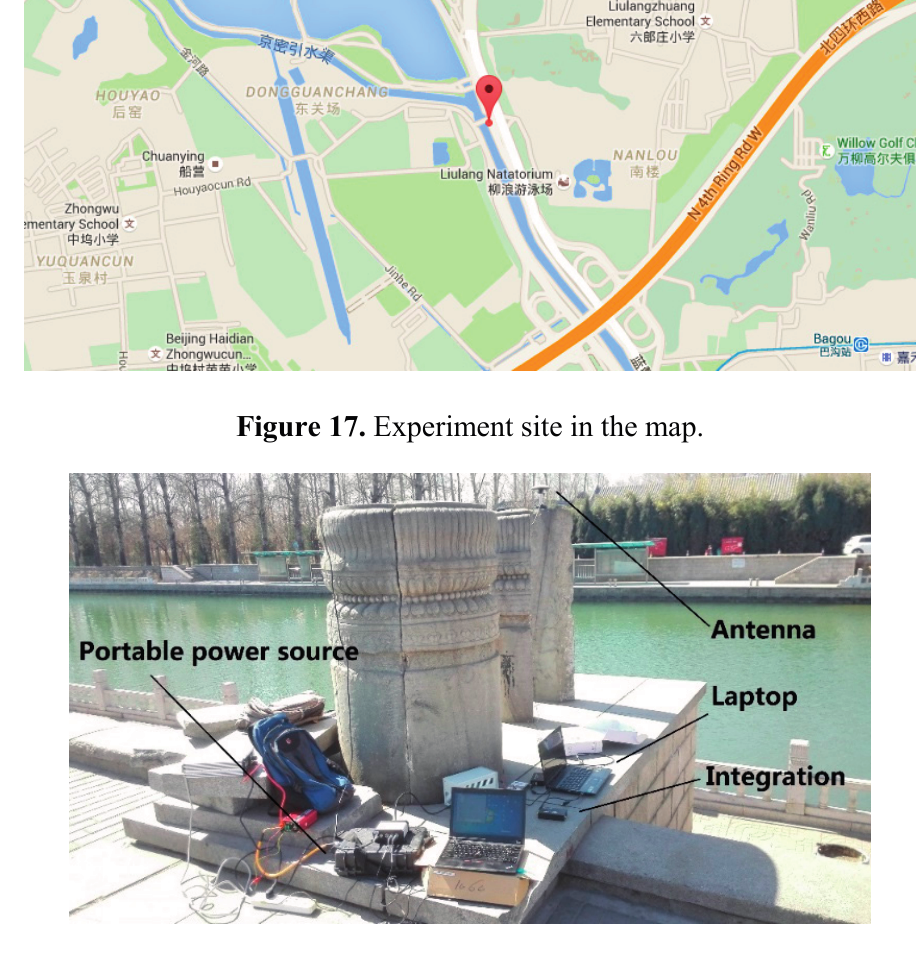
Figure 18. Experiment